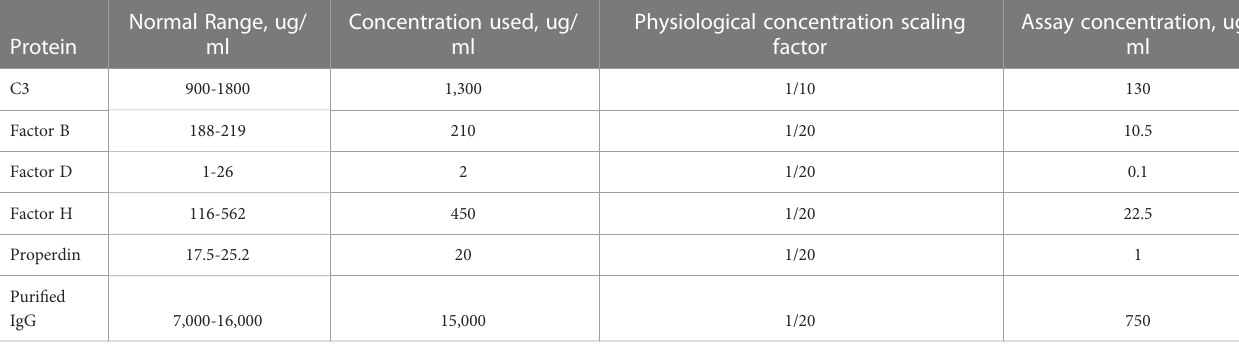
TABLE 2 Concentration of complement proteins in